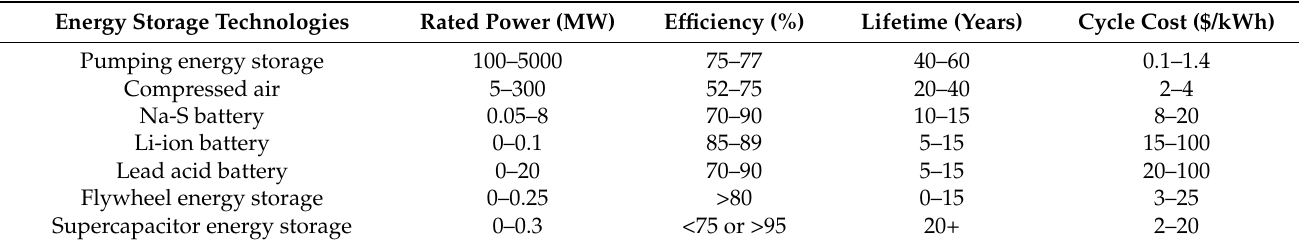
Table 1. Technical parameters of common energy storage technologies